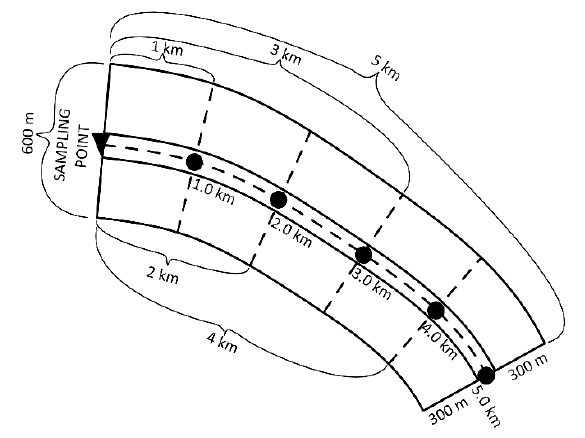
Figure 2. Scheme of land cover analysis.